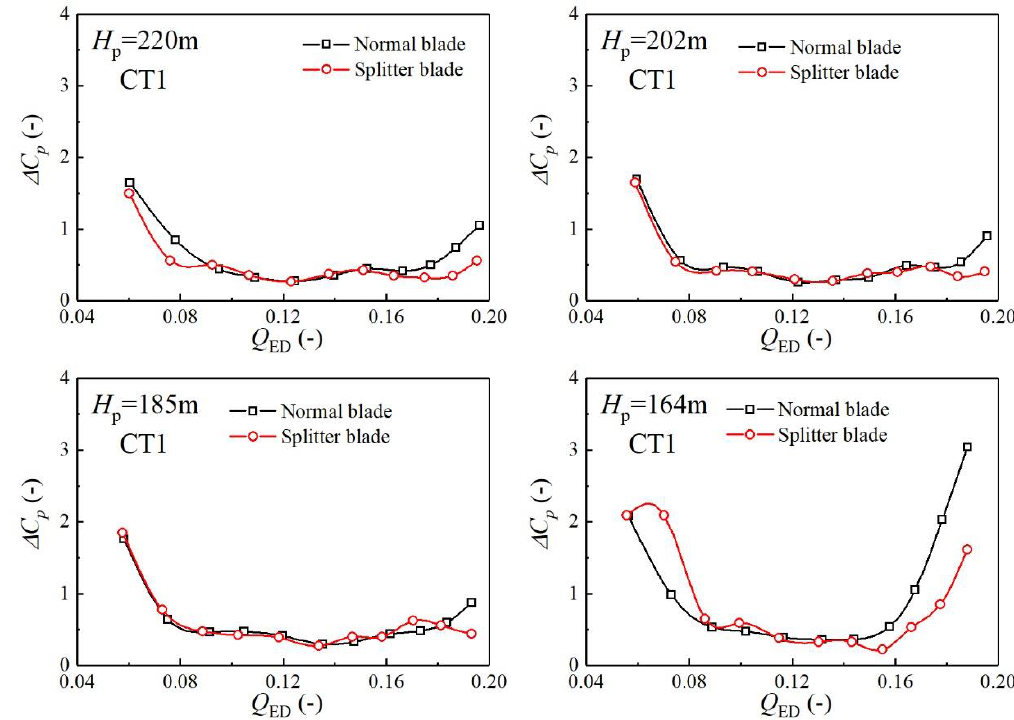
Figure 14. Peak-to-peak value in the cone of the draft tube at different heads.